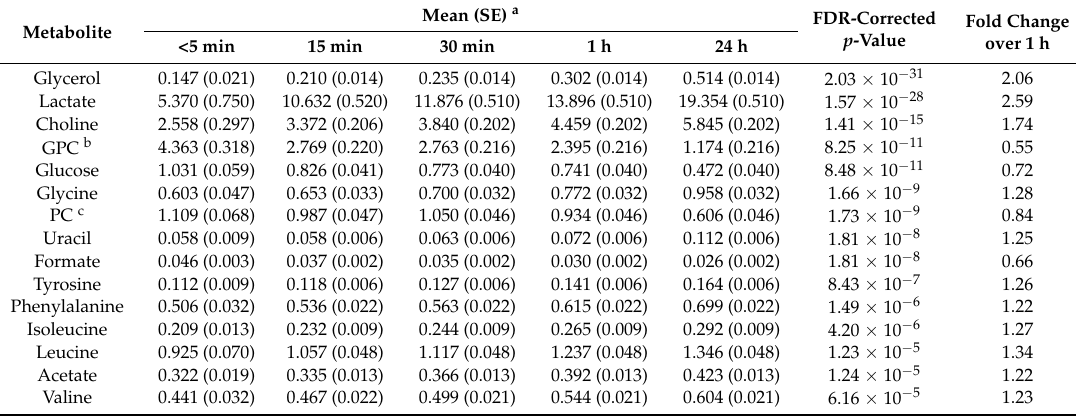
Table S2. Table 2. Metabolites abundance over 24 h on the surface of the maternal